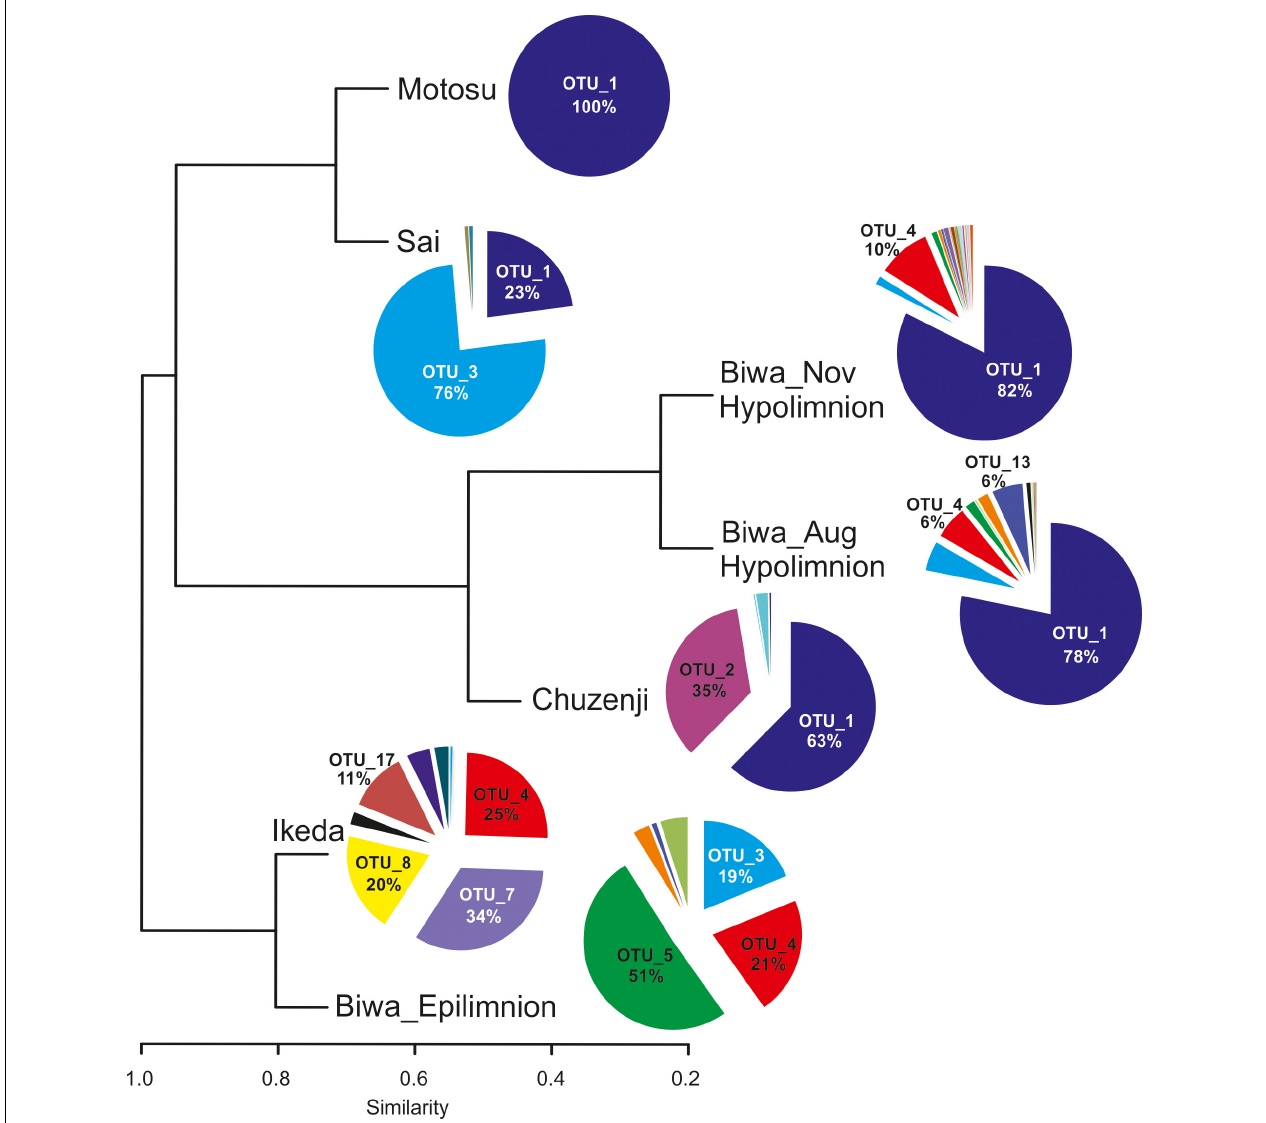
FIGURE 4 | Diversity of kinetoplastids and other euglenozoan flagellates in Japanese deep freshwater lakes using kinetoplastid-specific primers (based on sequence abundance of each OTU). The cluster dendrogram is based on a Bray-Curtis similarity